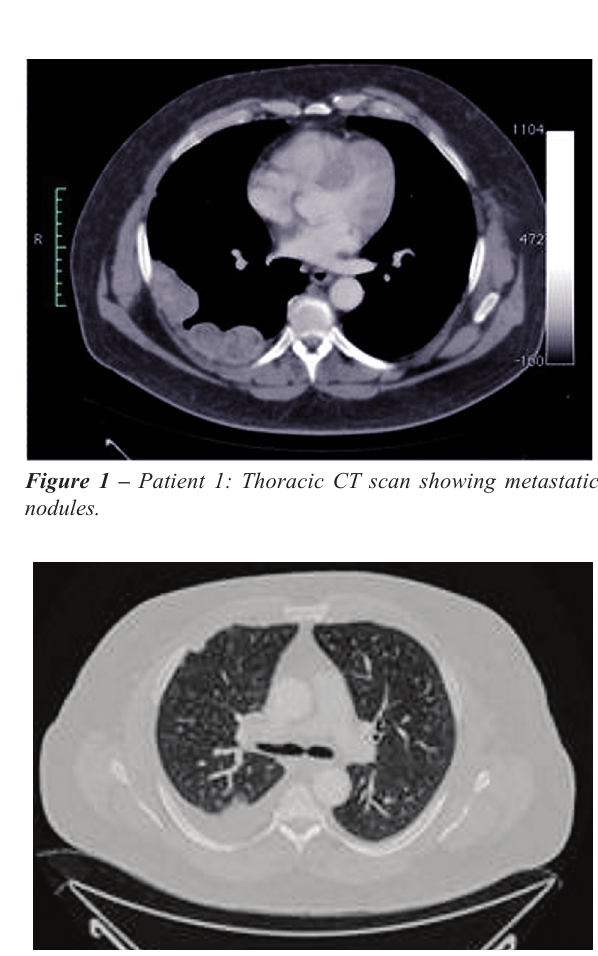
Figure 3 – Patient 1: CT scan with regression of the pleural ef- fusion without